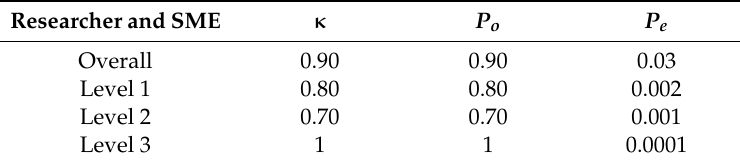
Table 5. Derived agreement statistics across all